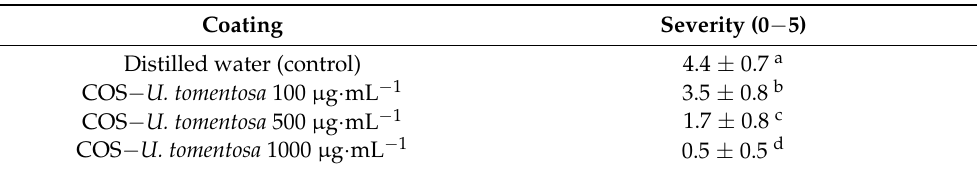
Table 5. Degree of severity of gray mold on strawberry fruits treated with COS − U. tomentosa conjugate complex 10 days after artificial inoculation with B. cinerea . Coating